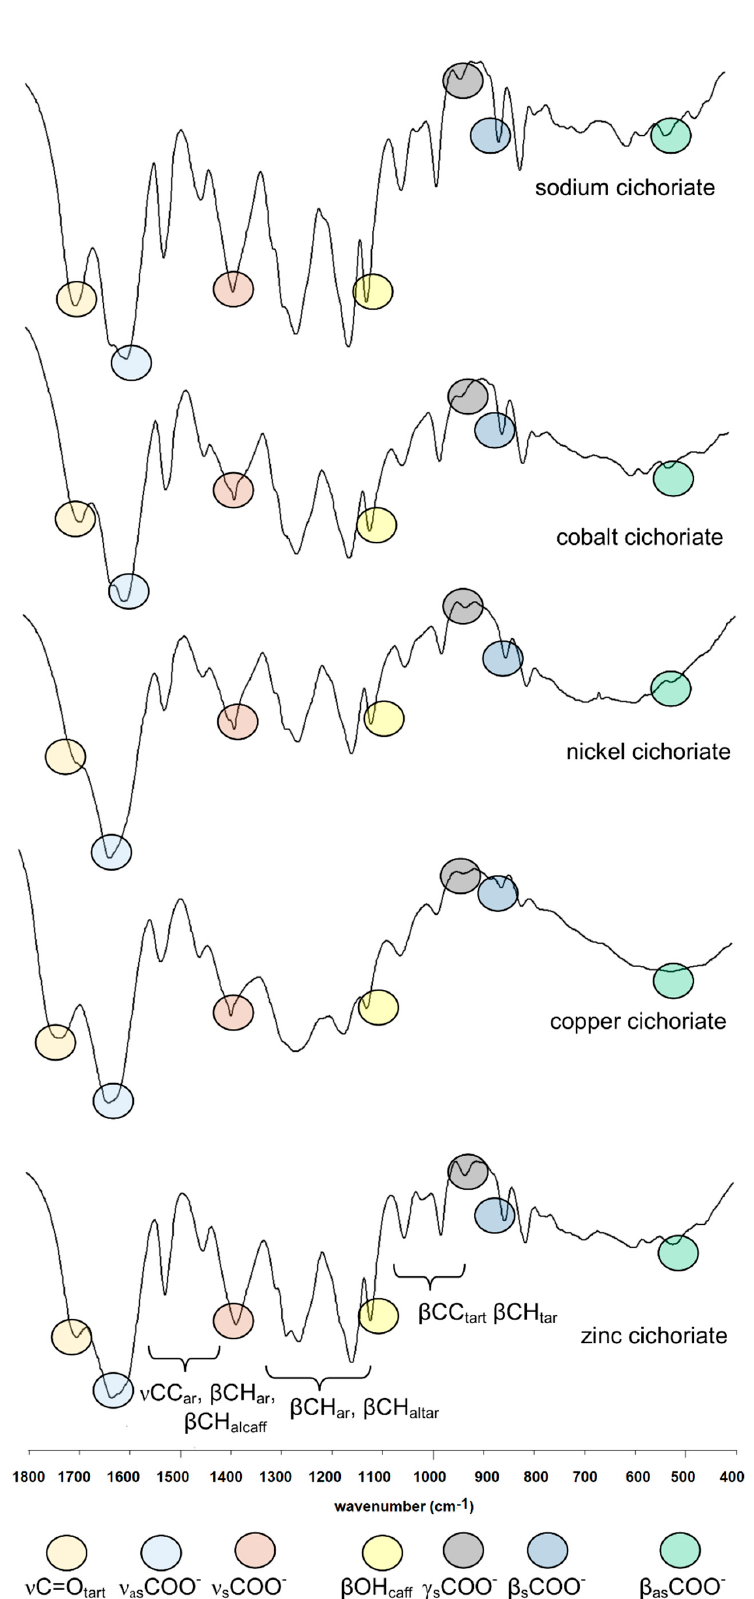
Figure 2. IR spectra of sodium salt and Co(II), Ni(II), Cu(II) and Zn(II) complexes of cichoric acid (400–1800 cm − 1